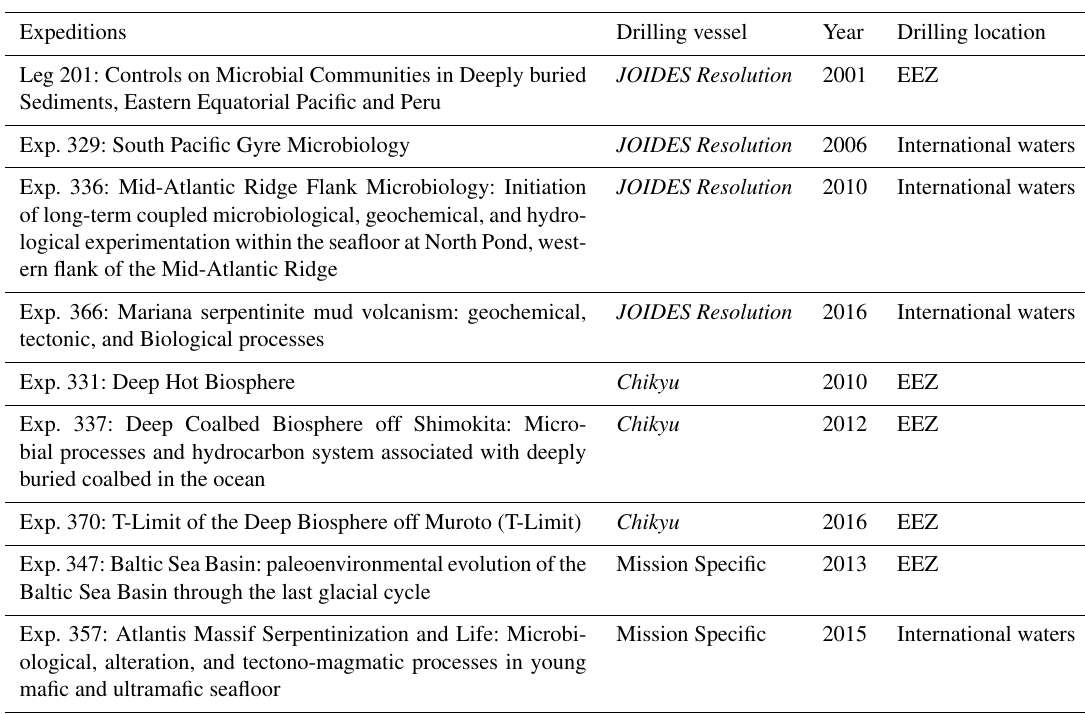
Table 2. List of ocean drilling expeditions that included deep biosphere research as a major scientific objective in their drilling proposals. Expeditions conducted by three drilling platforms from the Ocean Drilling Program, Integrated Ocean Drilling Program, and International Ocean Discovery Program are listed. EEZ: exclusive economic